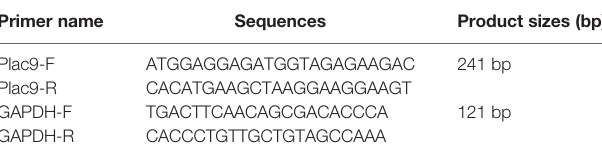
TABLE 1 | Sequences of primers used for Real-Time